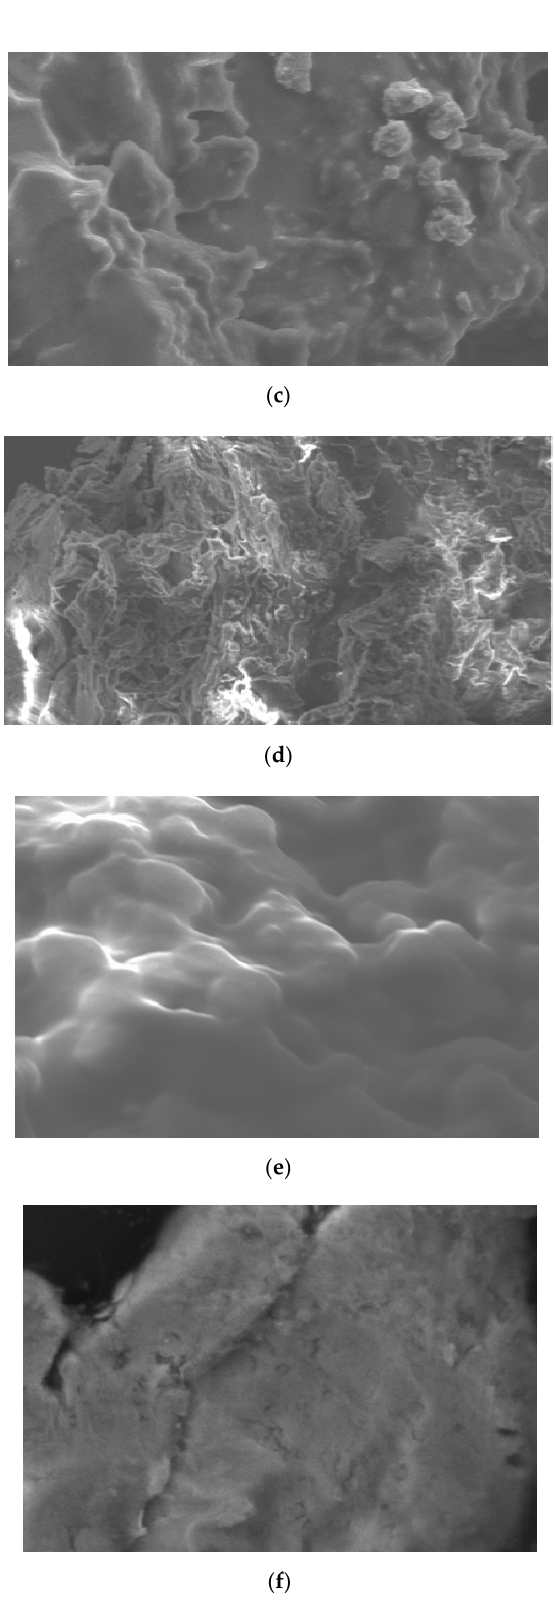
Figure 7. SEM analysis of the pretreated food waste at different time intervals. ( a ) Untreated food waste; ( b ) pretreated food waste at 20 min; ( c ) pretreated food waste at 40 min; ( d ) pretreated food waste at 60 min; ( e ) pretreated food waste at 80 min; ( f ) pretreated food waste at 100 min.